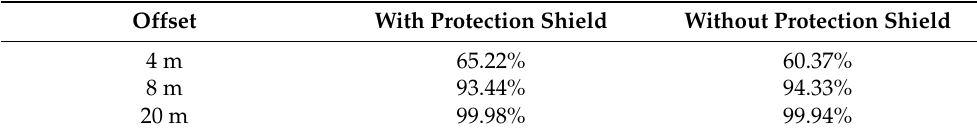
Figure 10. Numerical analysis results of settlement of pilot tunnel (point A). Table 4. Decreased rate of settlement at point A with an increase in separation distance between blasting point and protection shield.